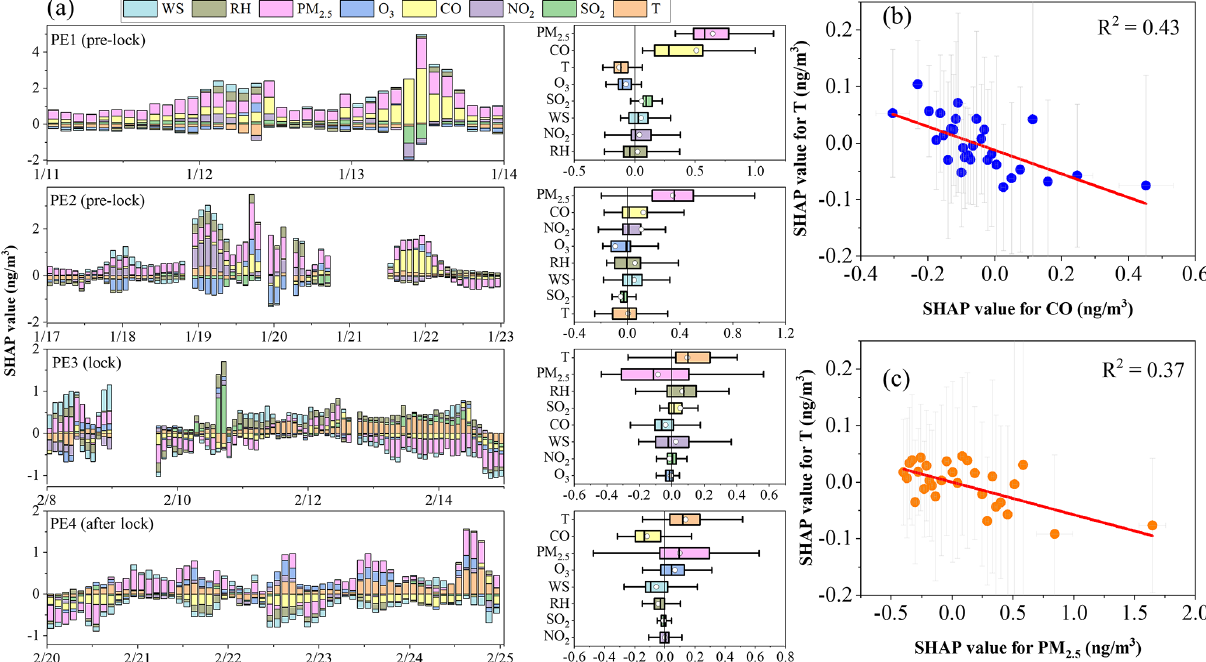
Figure 5. (a) Time series and box plots of each feature’s SHAP value during the four mercury pollution episodes. (b–c) Relationship between the SHAP value of temperature and SHAP value of CO and PM 2 . 5 during the whole study